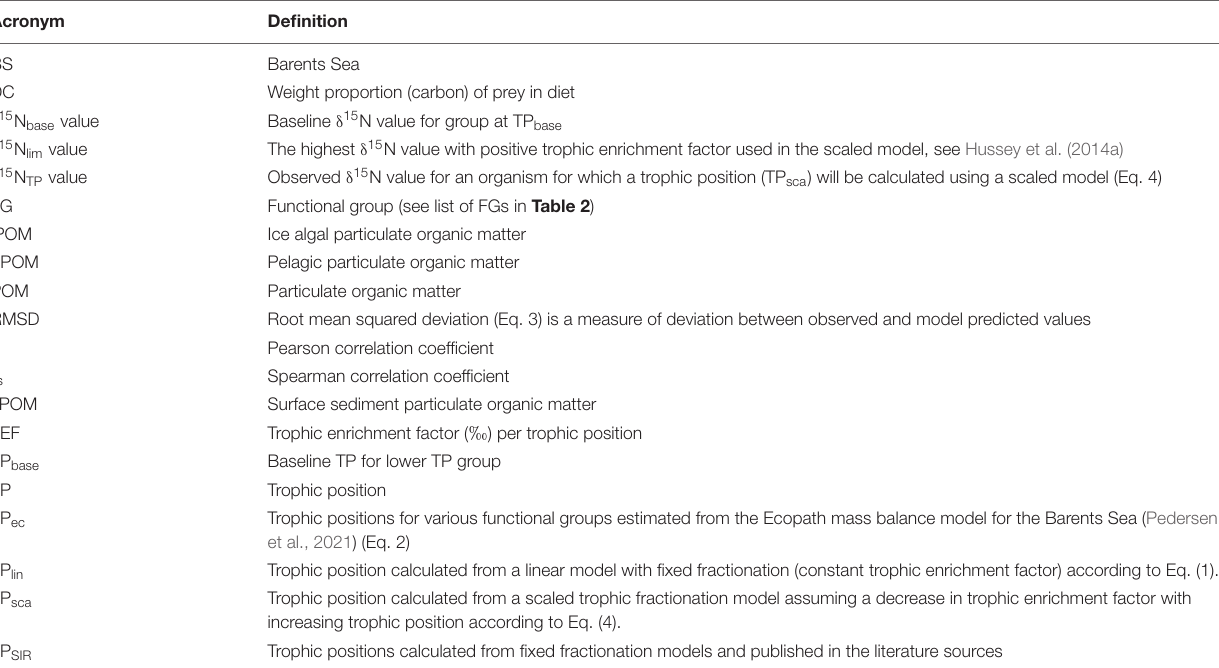
TABLE 1 | Overview of definition of acronyms in alphabetical